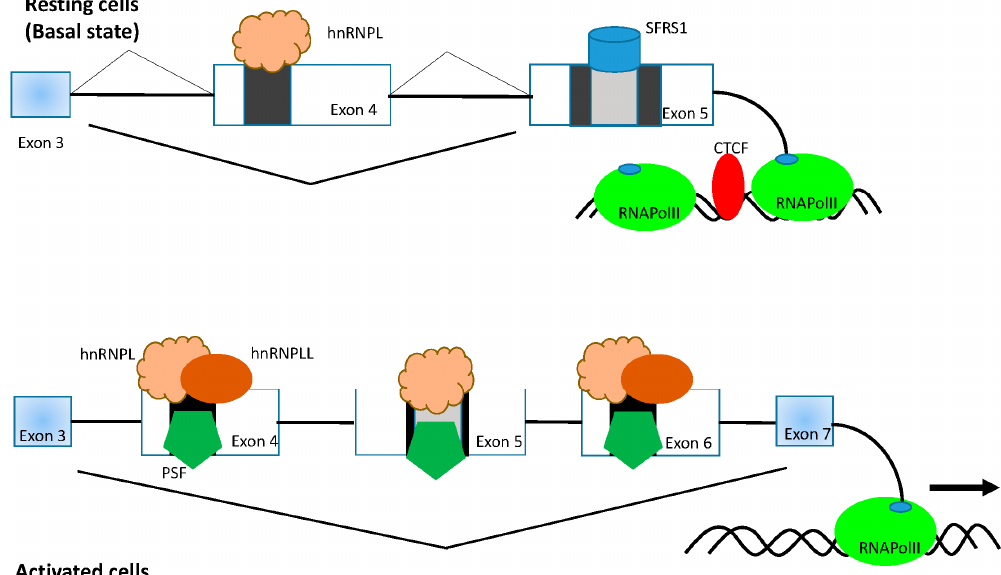
Figure 2. Alternative splicing of the Ptprc gene. The Ptprc gene can give rise to multiple isoforms through alternative splicing of pre-mRNA that involves three variable exons 4, 5 and 6. All three variable exons contain the ARS motif (black) and the ESE (black). The upper panel indicates the conditions of alternative splicing in T cells in the basal resting state. The hnRNPL protein mediates basal repression of exon 4 in resting cells, while the SR protein SRSF1 mediates the inclusion of exon 5. In addition, the CTCF protein can bind to the ESE sequence of exon 5 to mediate pausing of the RNAPII elongation to promote exon 5 inclusion. The bottom panel shows the alternative splicing of Ptprc gene following TCR activation. The proteins PSF and hnRNPLL are recruited to the exon 4 and exon 6 ARS together with hnRNPL to promote repression of both exons, while hnRNPL and PSF mediate repression of exon 5.